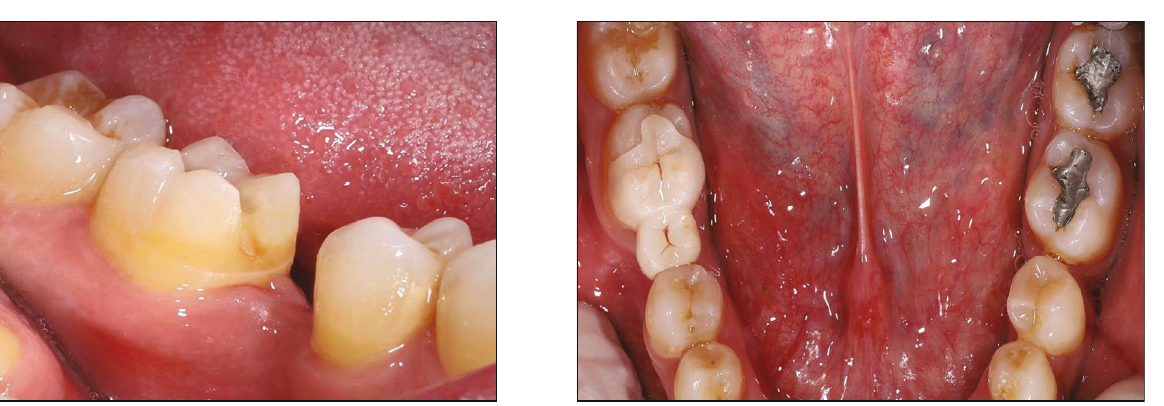
Figure 4: The mandibular right second molar after preparation.